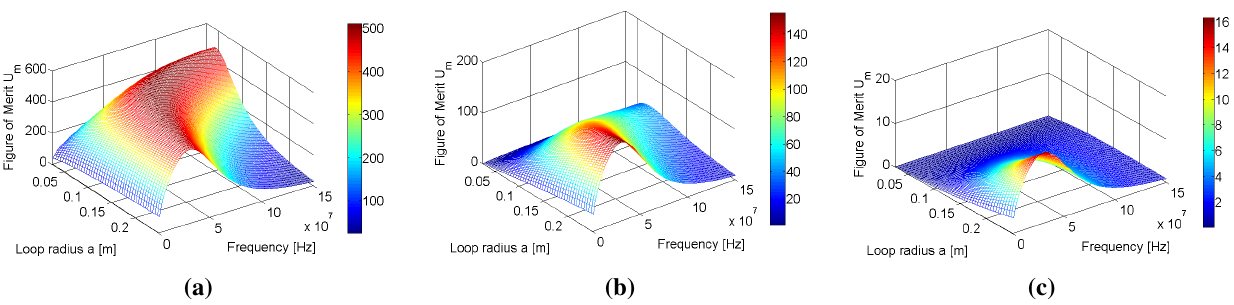
Figure 4. Variation of the figure of merit U frequency f and loop radius a for (a) d = 0 . 01 m, (b) d = 0 . 1 m and (c) d = 0 . 5 m for the 0 coaxial configuration.